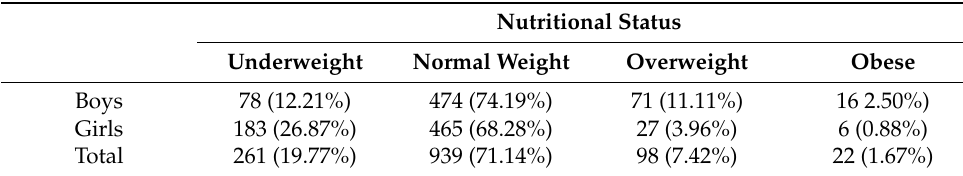
Table 1. Nutritional status of the lot studied.